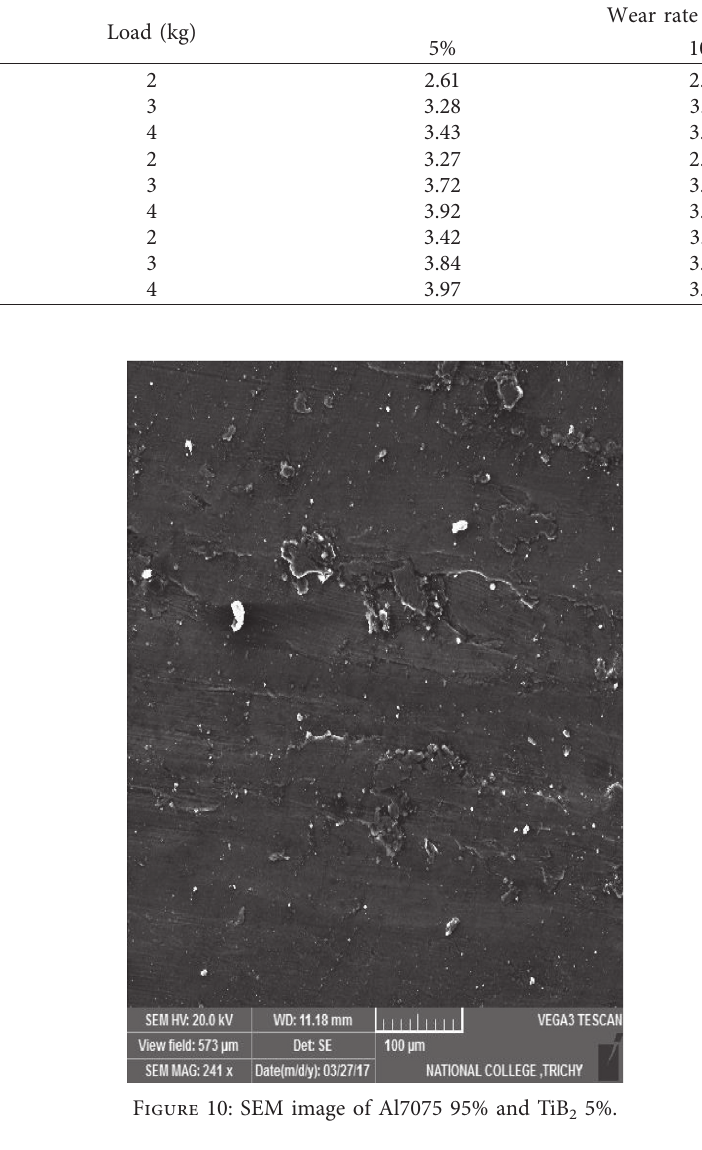
Table 4: Wear rate for prepared samples.